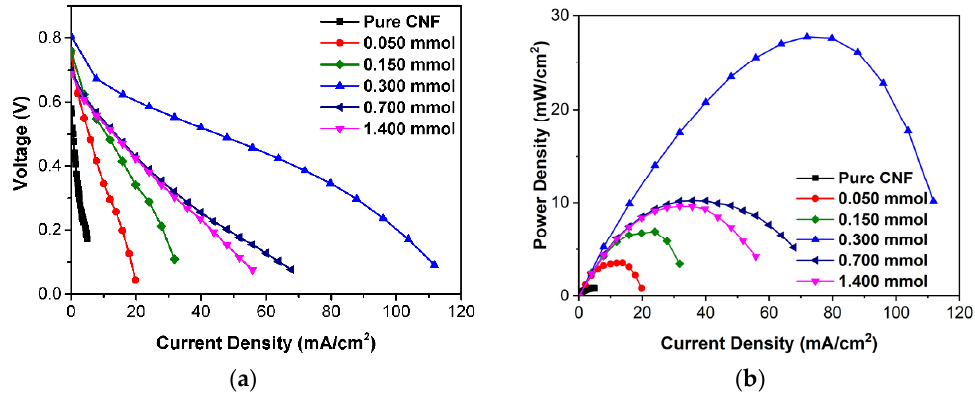
Figure 10. ( a ) Polarization curves and ( b ) power density curves of all membranes.